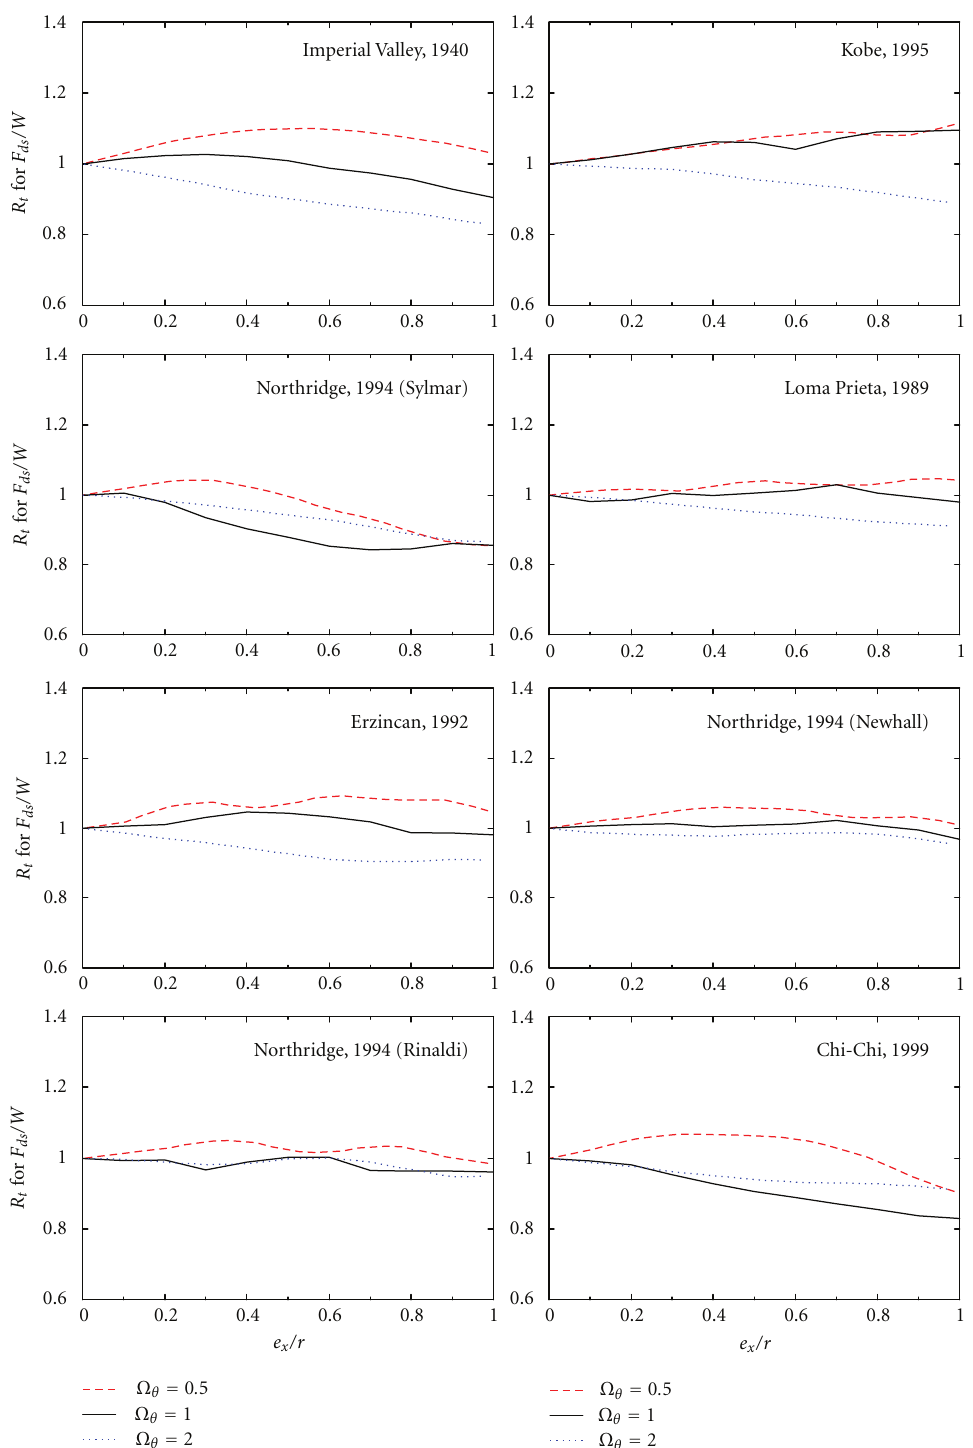
Figure 17: E ff ect of eccentricity on response ratio, R t for normalized sti ff edge RMS damper force ( T y =